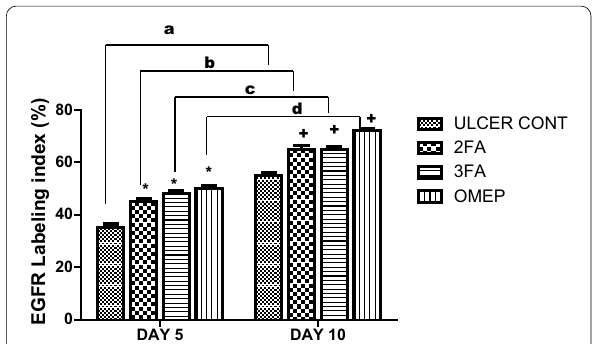
Fig. 21 Labelling index of EGFR in healing ulcerated stomach treated with folic acid and Omeprazole (* p < 0.05 cf ulcer control; a–d p < 0.05 cf. each group on day 10). ULCER CONT Ulcer control, 2FA